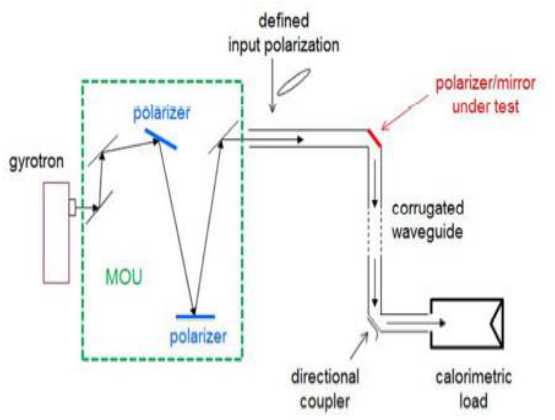
Fig. 1. Measurement setup